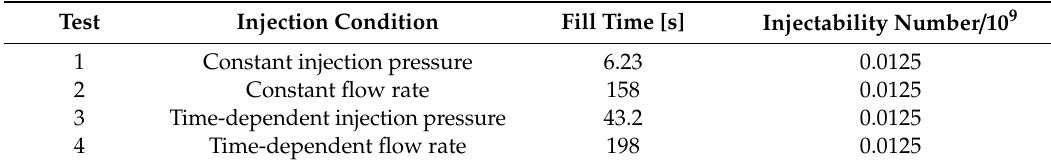
Table 4. Fill times and injectability numbers for peripheral injections.